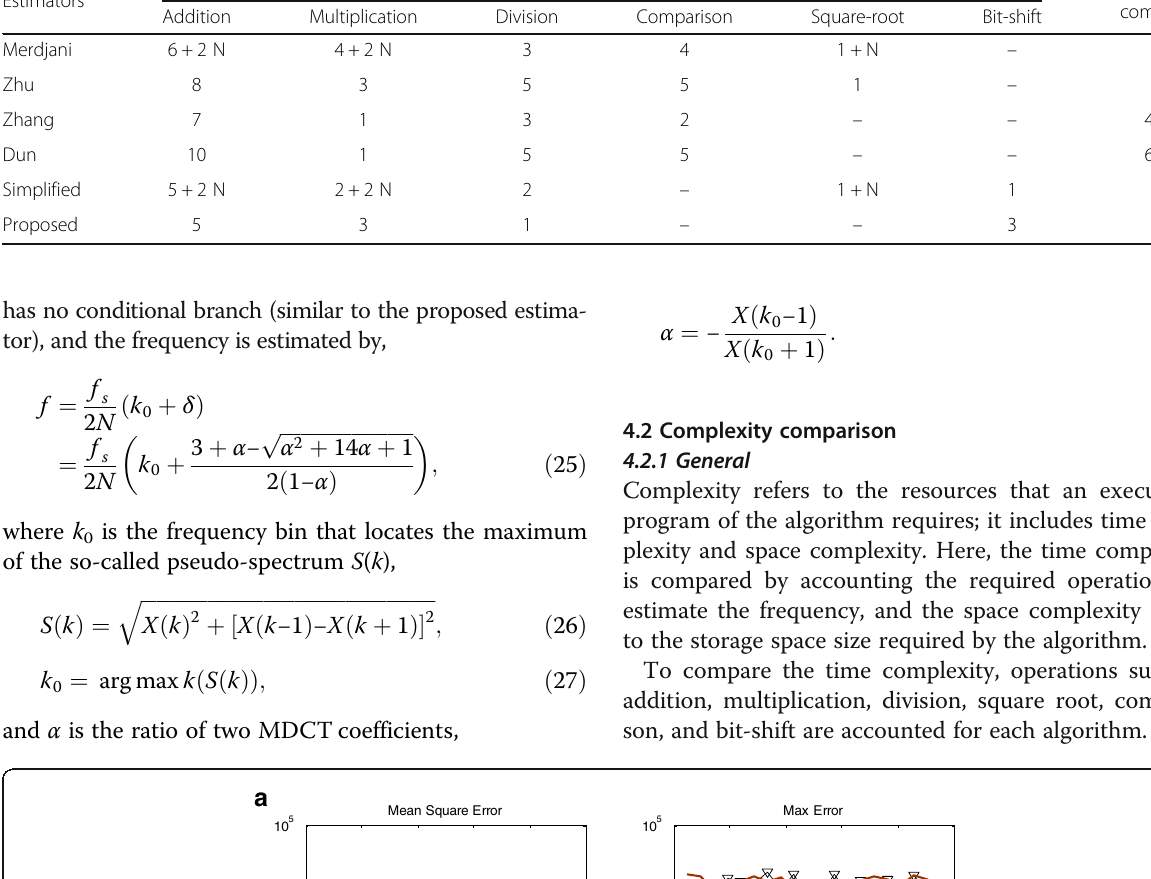
Table 1 Comparison of the complexity Estimators